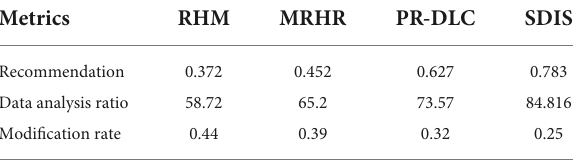
TABLE 3 Comparative analysis for varying S H .